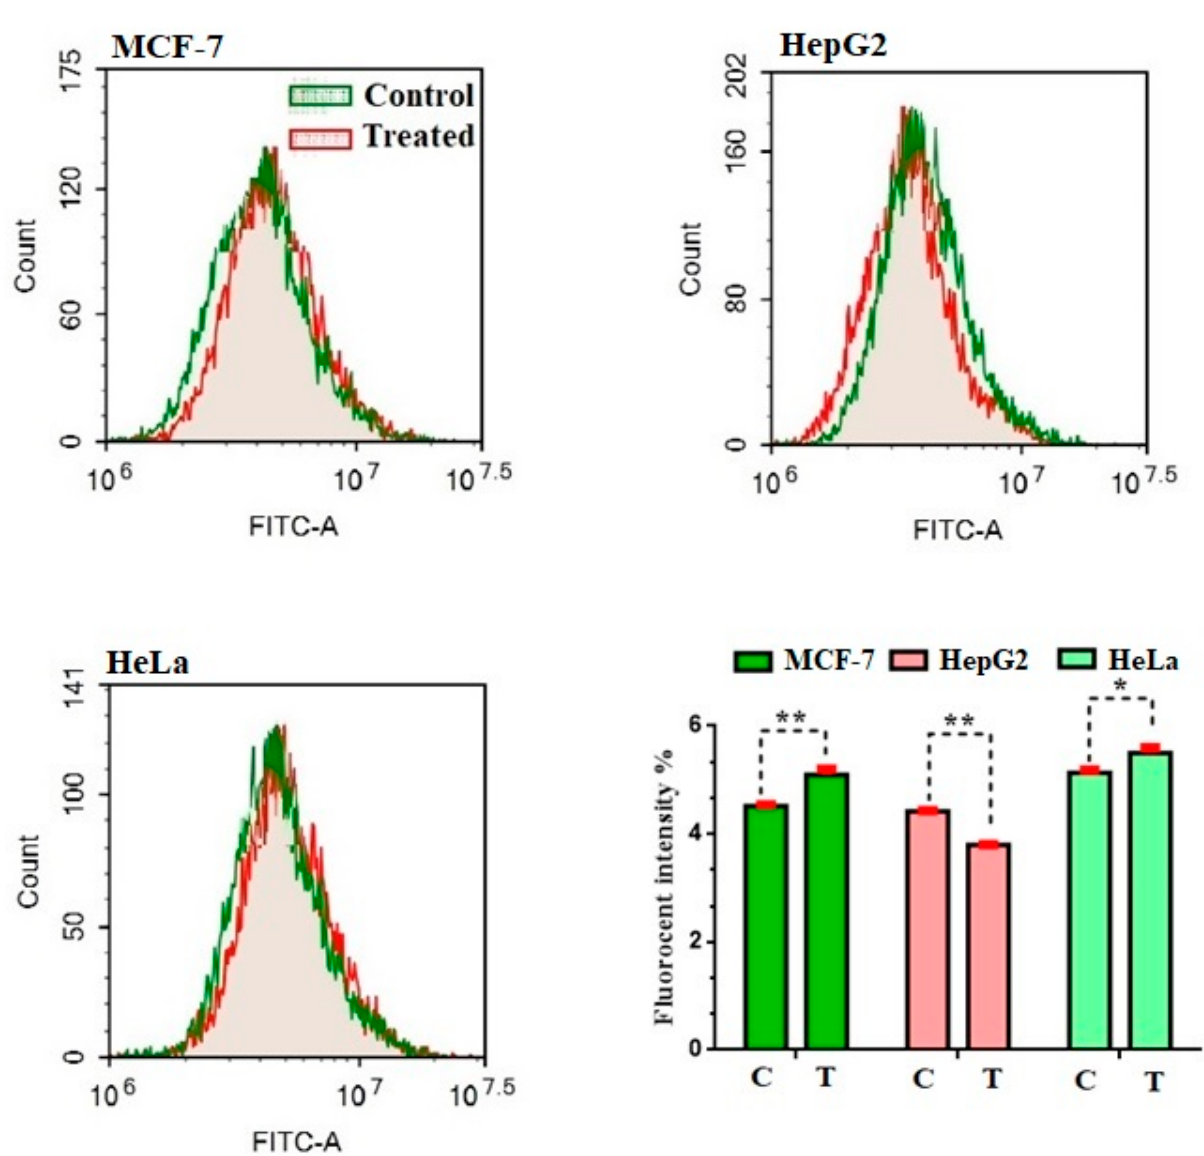
Figure 4. Effect of compound 2 on the autophagy cell death in MCF-7, HepG2, and HeLa cells. Ex- posure to treatments for 48 h. Data are presented as the mean ± SD; n = 3; * p < 0.05, ** p < 0.01 and *** p <